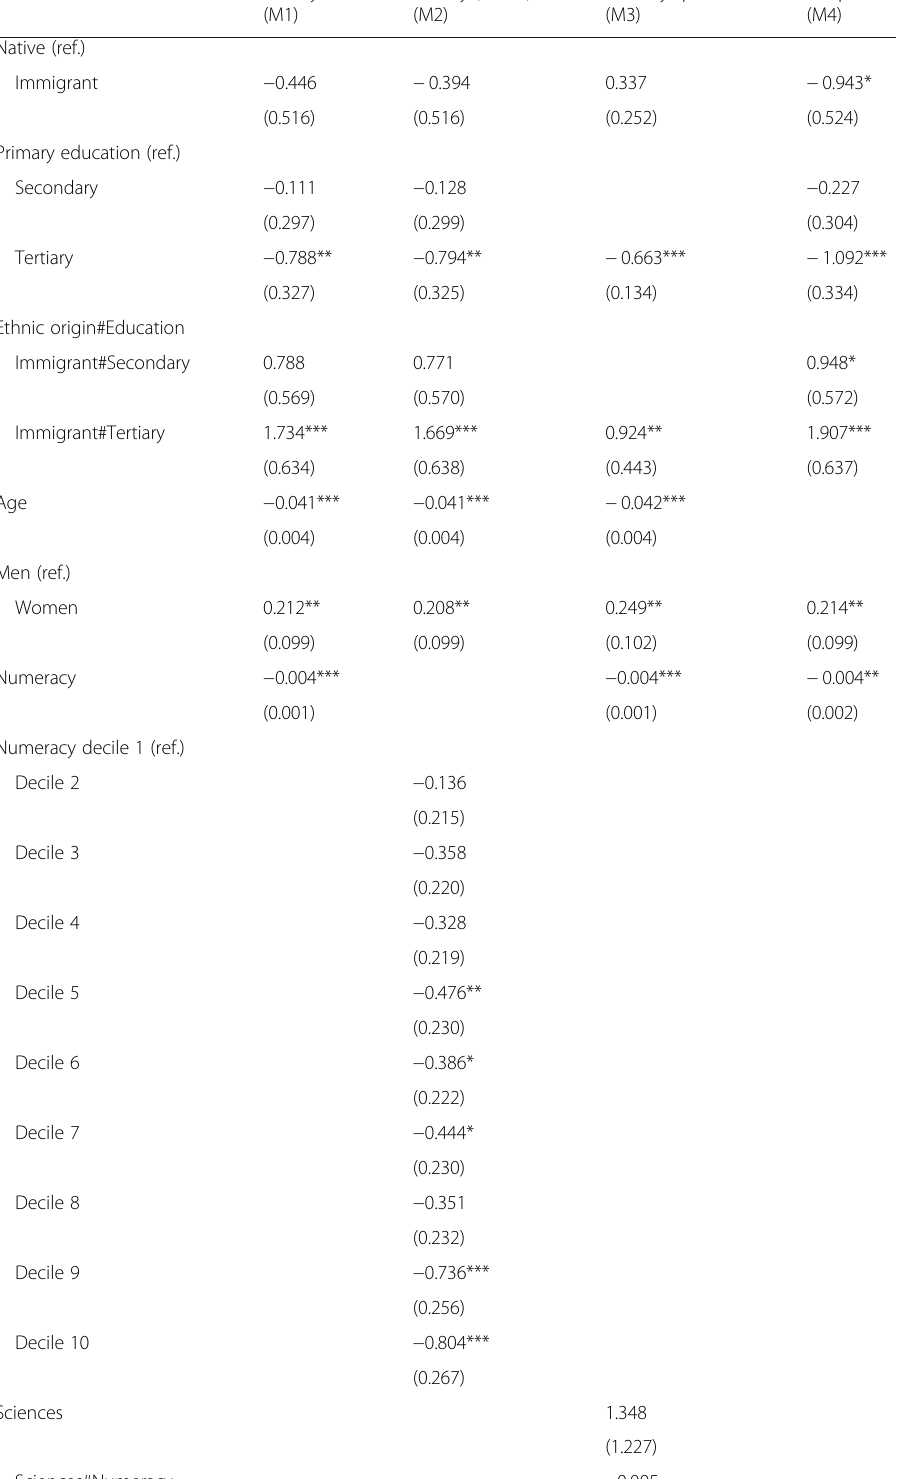
Table 5 Logistic regression on the probability of being unemployed. Explanations for the ethnic gap between natives and immigrants settled in France